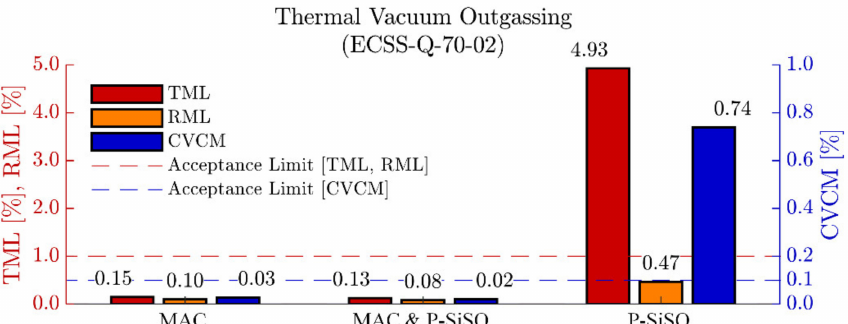
Figure 2. Thermal vacuum (125 ◦ C and <10 − 3 Pa) outgassing test for screening of space materials, in accordance to standard ECSS-Q-70-02. The outgassing performance in terms of total mass loss (TML), relative mass loss (RML), and collected volatiles condensable material (CVCM) is within the acceptance limits for neat MAC, and MAC with 0.4 wt% P-SiSO (MAC and P-SISO). Neat P-SiSO display TML and CVCM outside the acceptance limit, while RML is